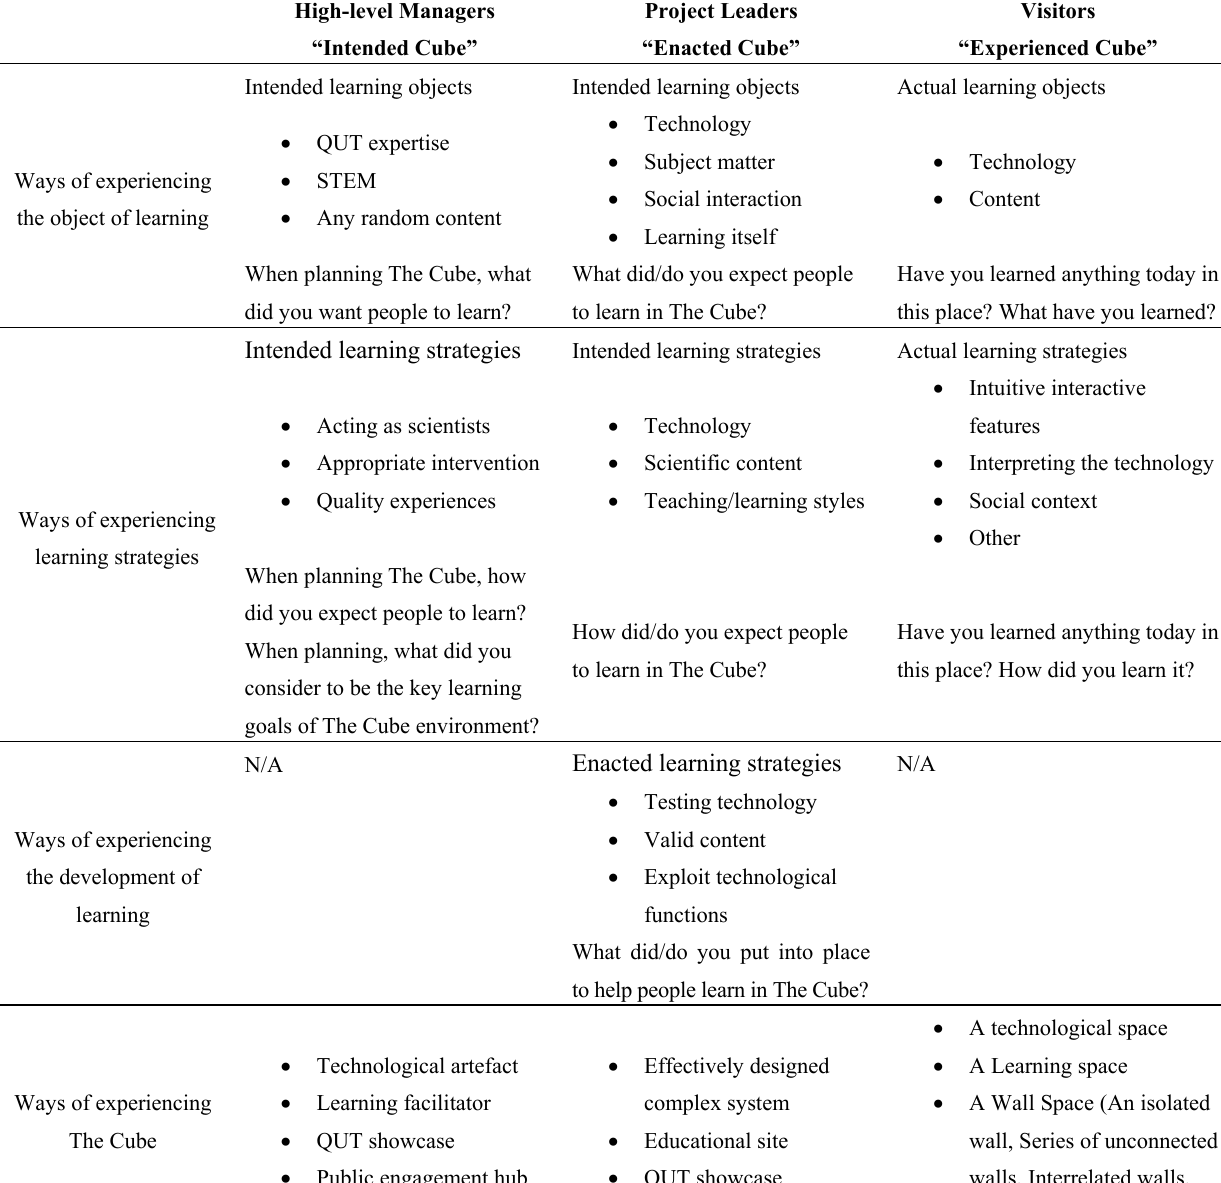
Table 3. The experience of learning in The